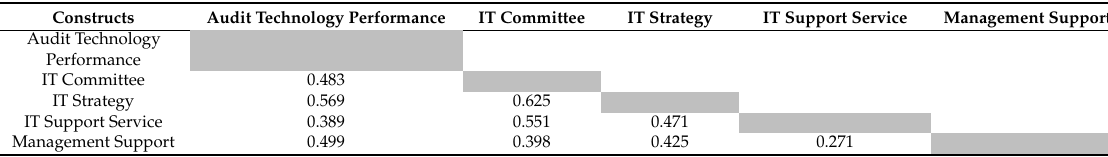
Table 4. Discriminant validity using heterotrait-monotrait (HTMT) criterion (Henseler et al.